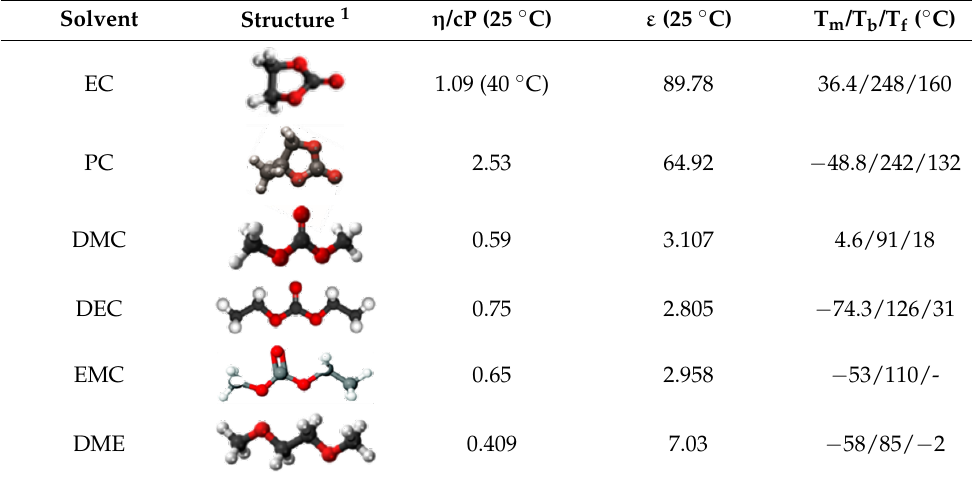
Table 1. Molecular structure, viscosity (η), dielectric constant (ε), melting point (T m ), boiling point (T b ), and low flash point (T f ) of most used carbonate- and ether-based solvents for PIBs.